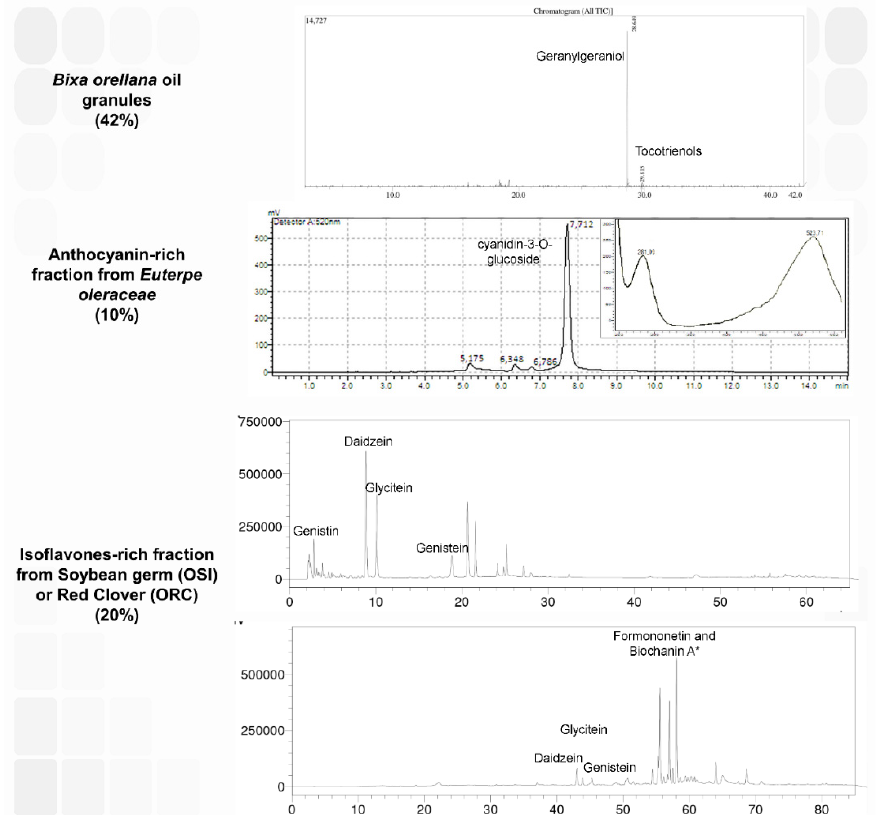
Figure 7. Profile of High Performance Liquid Chromatography (HPLC) analysis of the components of the nutraceuticals Ormona ® SI (OSI) and Ormona ® RC (ORC). The data and methods of evaluation have been published and can be found in [7] ( Bixa orellana granules), [20] ( Euterpe oleraceae extract), and [1] (isoflavone-rich fractions). *: It is presumed that two of these peaks represent formononetin and biochanin A based on the literature about red clover.